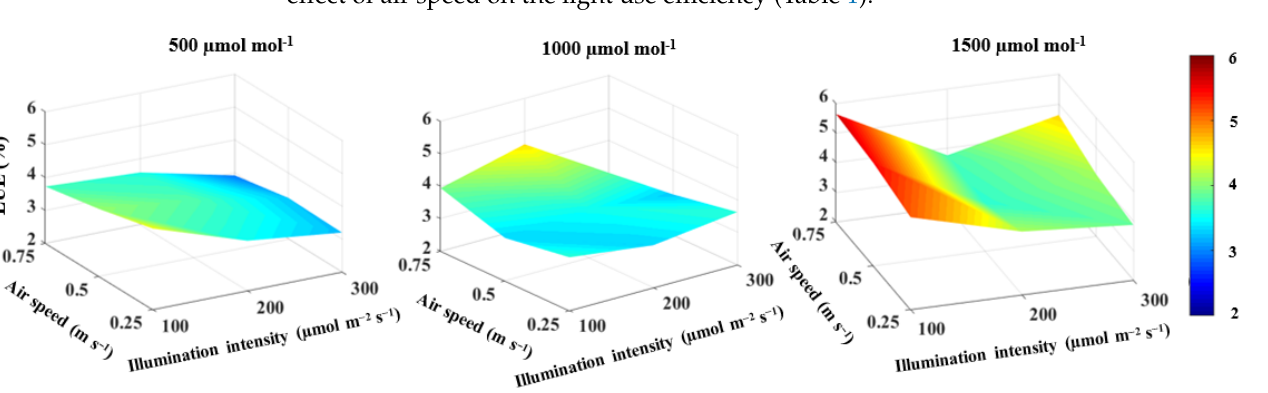
Figure 6. Effect of CO 2 concentration, illumination intensity and air speed on light use efficiency (LUE) of lettuce plants grown under artificial